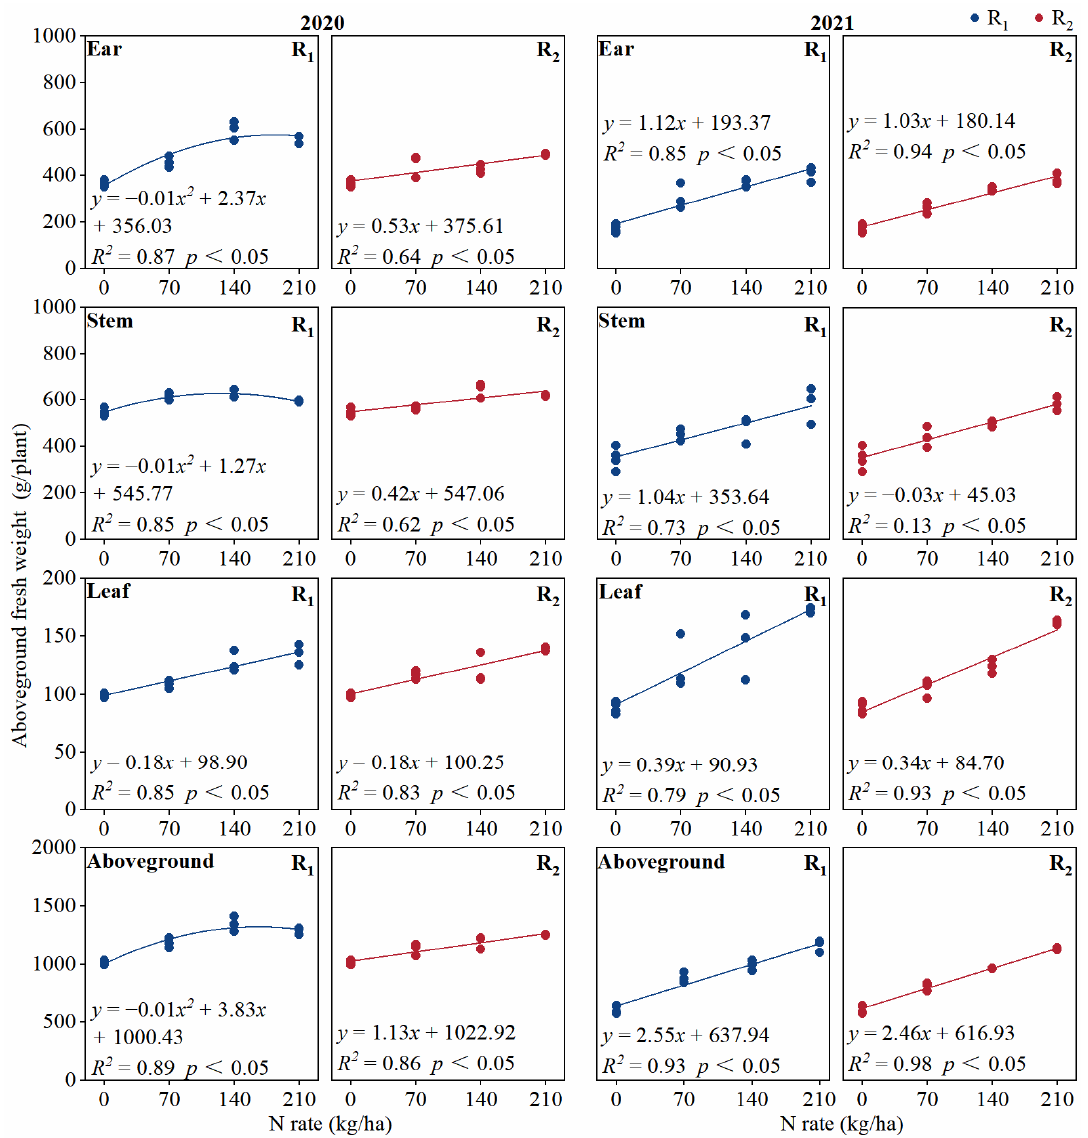
Figure 4. Fresh weights of forage maize plants at harvest under different treatments in 2020 and 2021.